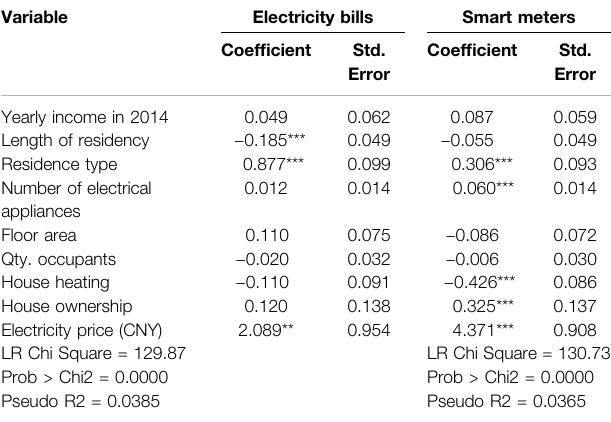
TABLE 4 | Determinants of information